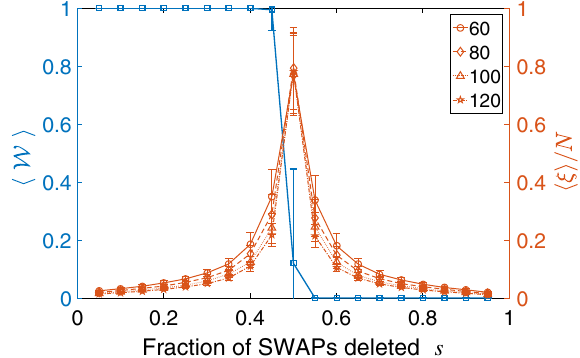
FIG. 3. Edge and bulk characterization of the “ diluted ” SWAP model. Each data point corresponds to the disorder average of 200 disorder realization, with the standard deviation indicated as error bars. Plotted against the right axis is the localization length ξ . Note that h ξ i was computed for N × N systems with PBC, where N ¼ 60 , 80, 100, and 120. As shown in the plot, the system is localized for small and large values of s , but it is delocalized around s ¼ 0 . 5 . Accompanying the delocalization is a change in the edge behavior, as can be seen in the data on W , plotted against the left axis. W is defined as follows: The edge ˆ Y operator for each disorder realization is computed following the discussion near Eq. (17), using a 100 × 100 system in the cylindrical geometry periodic in x but open in y . Regardless ˆ Y of s , can be interpreted as an element of the site permutation group and hence can be factorized into mutually commuting terms, with each term being an oriented “ loop ” in the lattice (Appendix A). The edge operator at a single edge is identified by restricting to the loops that are strictly contained within the lower half of the system, and W is defined as the net winding number of these loops about the cylinder axis. Note that W ¼ 1 and 0, respectively, indicate a chiral and a nonchiral edge operator. Note that W is not well defined near s ¼ 0 . 5 , where h ξ i and N become comparable, and therefore h W i is not quantized in that